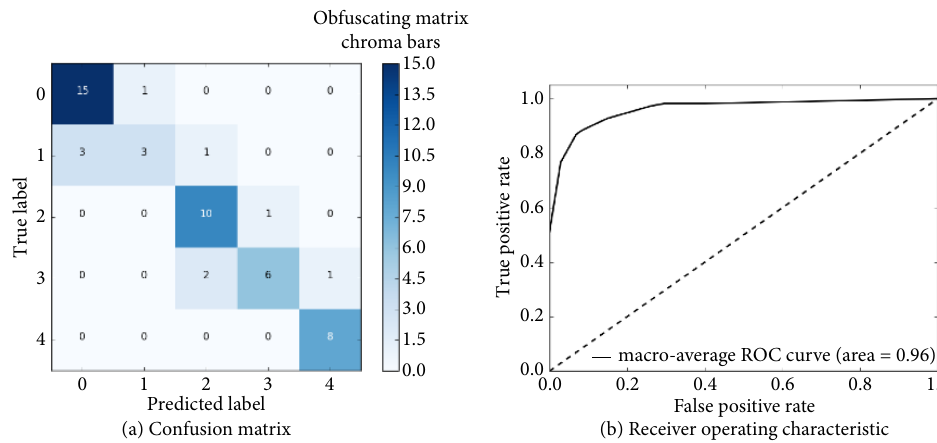
Fig. 6 Confusion matrix and ROC curve of k-NN